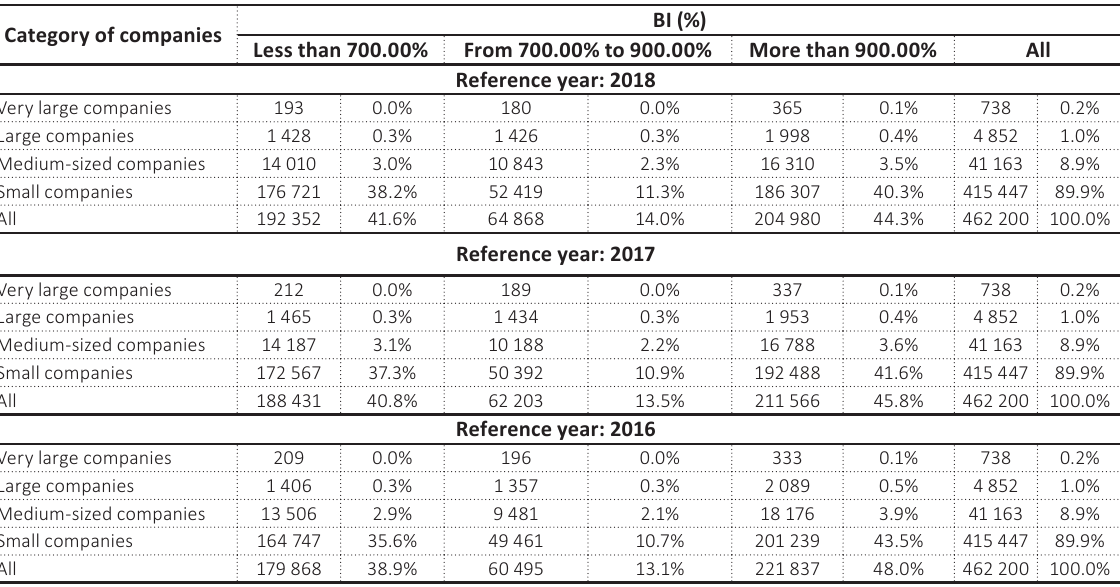
Table 5. Bankruptcy Index values of the total of active Hungarian companies grouped by size